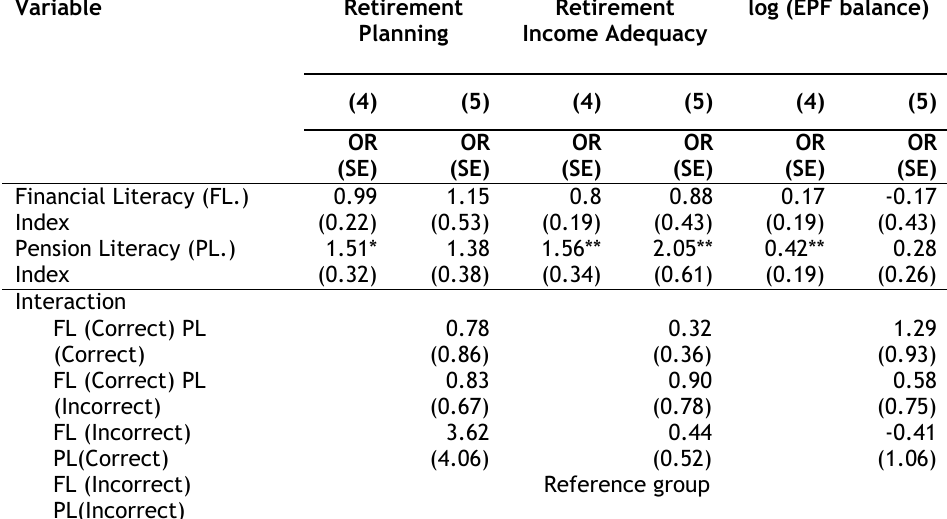
Table 6. Robustness check of financial literacy and pension literacy